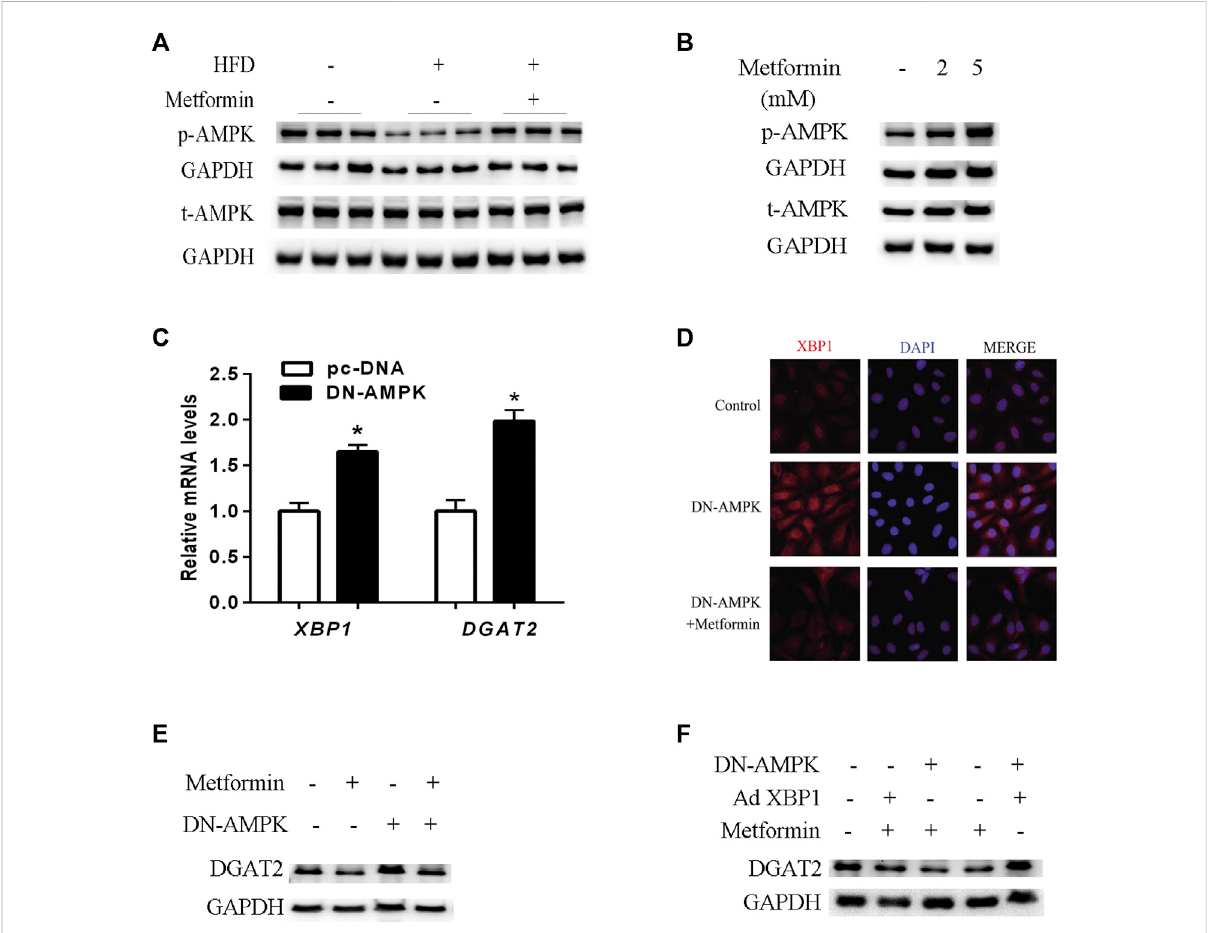
FIGURE 5 AMPK regulated the effect of metformin on TG synthesis via the XBP1-mediated DGAT2 pathway. (A) p-AMPK (Thr172) and total AMPK protein (t-AMPK) levels of mice fed control diet, HFD, or HFD with or without metformin treatment for 5 weeks; n = 6 – 8. (B) p-AMPK and t-AMPK levels in HepG2 cells treated with 2 mmol/L or 5 mmol/L metformin for 24 h. (C) Relative levels of XBP1 and DGAT2 mRNA in HepG2 cells transfected with dominant negative (DN)-AMPK α 1 plasmid or pc-DNA empty vector for 48 h. Data are presented as the mean ± SEM. p p < 0.05 compared with control cell, respectively. (D) Immuno fl uorescence images of XBP1 and DGAT2 protein in HepG2 cells transfected with DN-AMPK α 1 plasmid in the presenceorabsenceofmetforminfor48 h (E) DGAT2proteinlevelsinHepG2cellstransfectedwithDN-AMPK α 1plasmidinthepresenceorabsence ofmetforminfor48 h (F) DGAT2proteinlevelsinHepG2cellsco-transfectedwithDN-AMPK α 1plasmidorrecombinantadenovirusexpressingXBP1 (Ad XBP1) in the presence or absence of metformin for 48 h. These experiments were repeated at least three times. Representative blots of independent experiments are shown. GAPDH was used as a loading